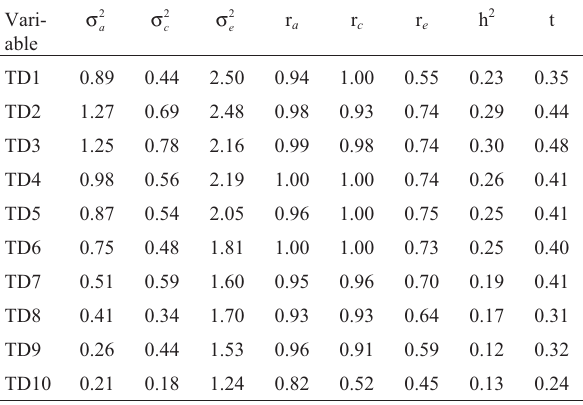
2 ), permanent environmental a